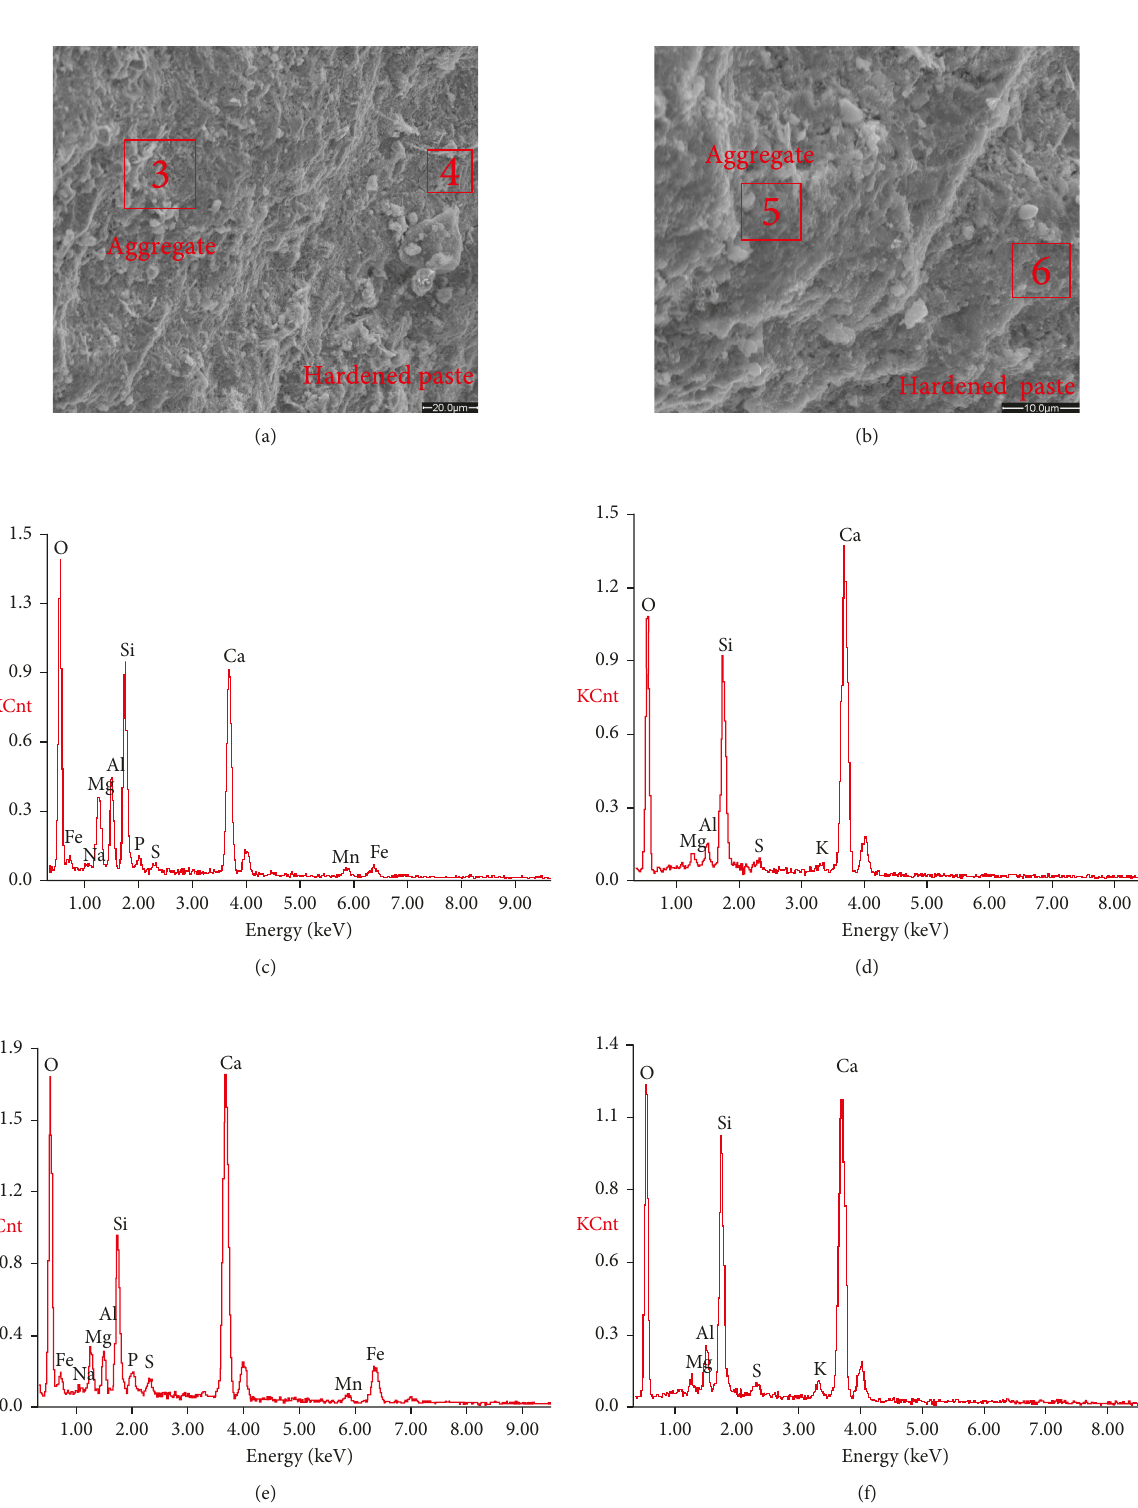
Figure 7: (a) SEM morphology of the fracture surface of concrete AS1 at 28d. (b) SEM morphology of the fracture surface of concrete AS2 at 28d. (c) EDX spectrum of position 3. (d) EDX spectrum of position 4. (e) EDX spectrum of position 5. (f) EDX spectrum of position